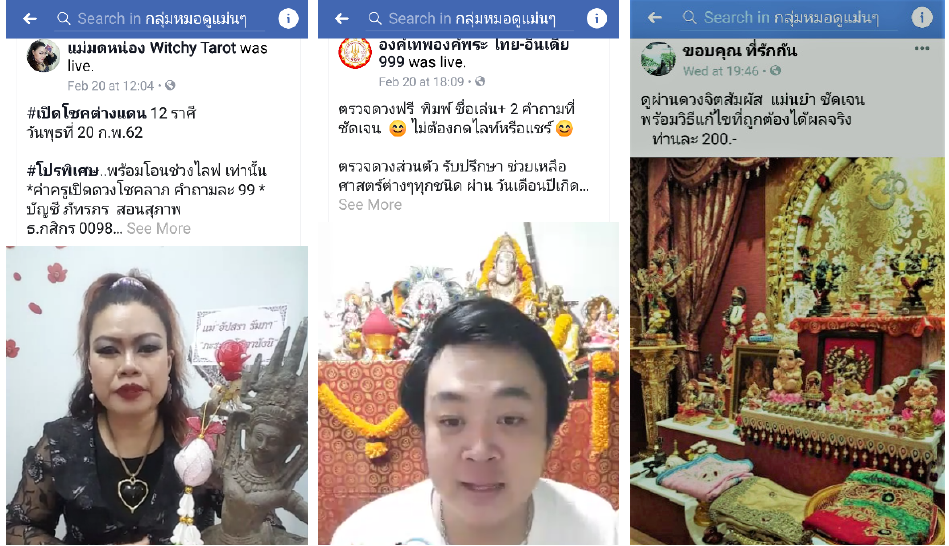
Figure 3. Tarot card reader and Fortune Teller providing services on social media site Facebook. The Thai text refers to the different promotions the fortune tellers have for the visitors of the FB page. For example, in the first image the tarot reader will provide her services to only those who pay for her services during the live broadcast on 20 February 2019. The fortune teller in the second image answers two questions of those who watch his live broadcast for free. He also provides personal fortune reading and consultation to those interested. The third image mentions that their fortune reading is very accurate and gives quick results and a fee of 200 baht is charged for the services. Source: Accurate Fortune Tellers’ Group, Facebook. Retrieved on 20 February 2019. Images used with permission.